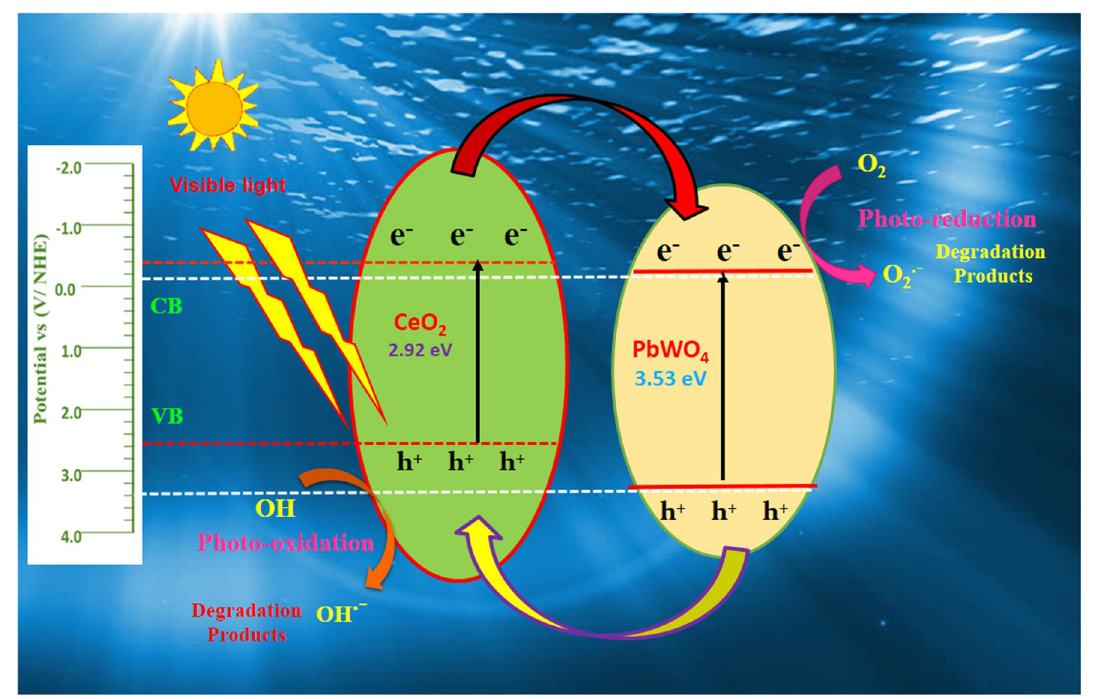
2 /PbWO 4 photocatalytic inter-